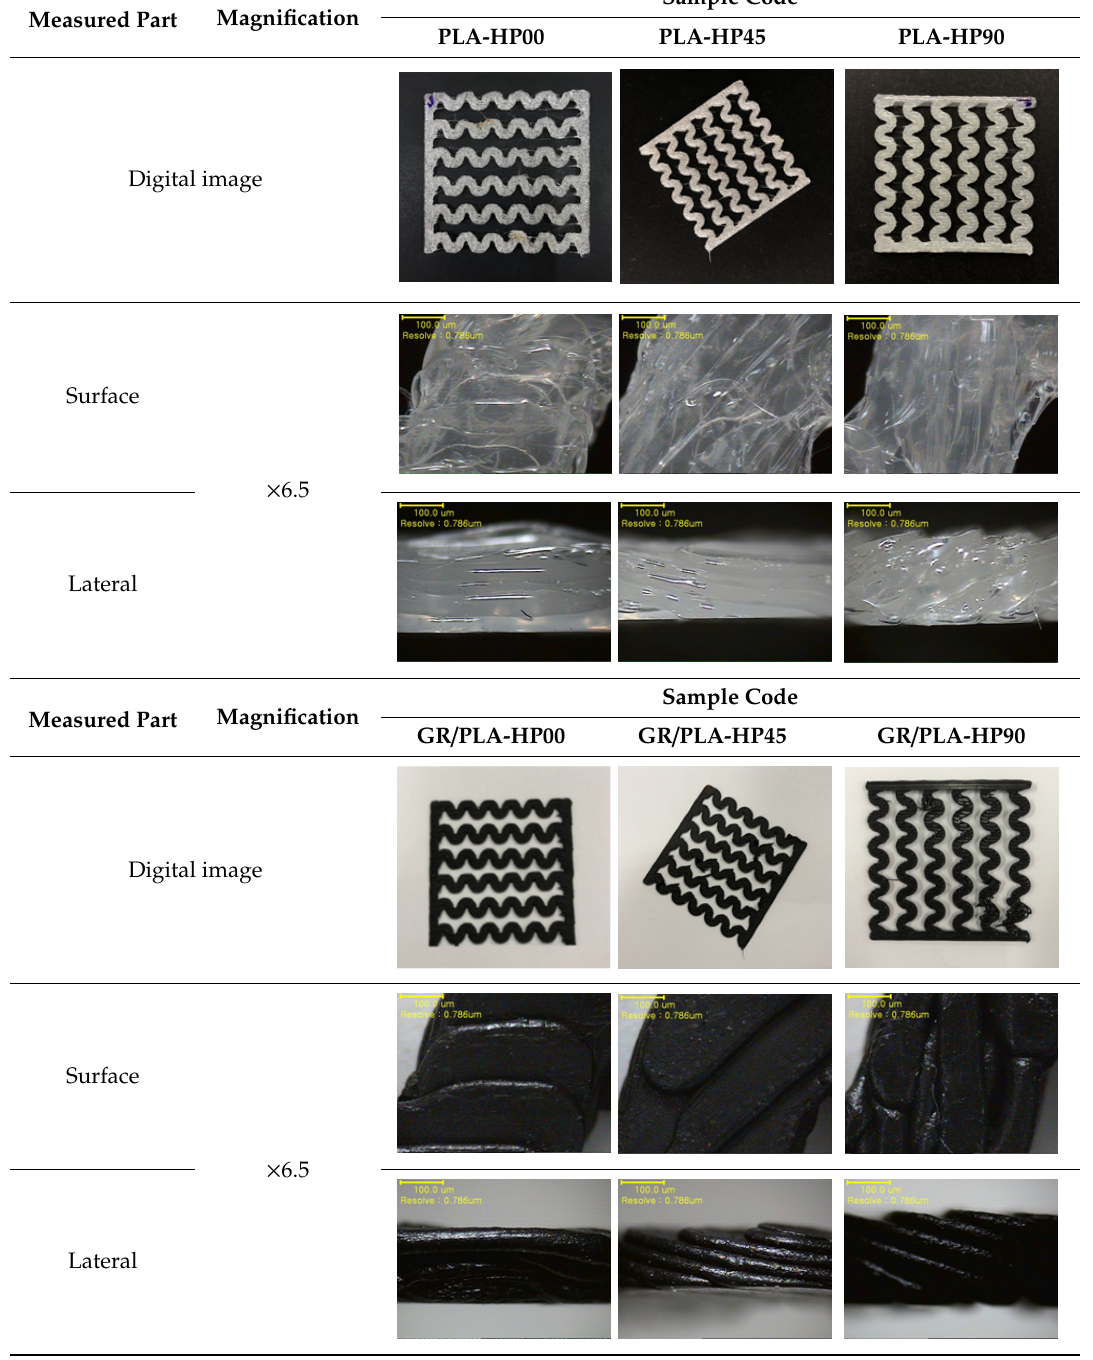
Table 4. Morphology of CFDM 3D-printed horseshoe pattern by different 3D printing direction. Measured Part